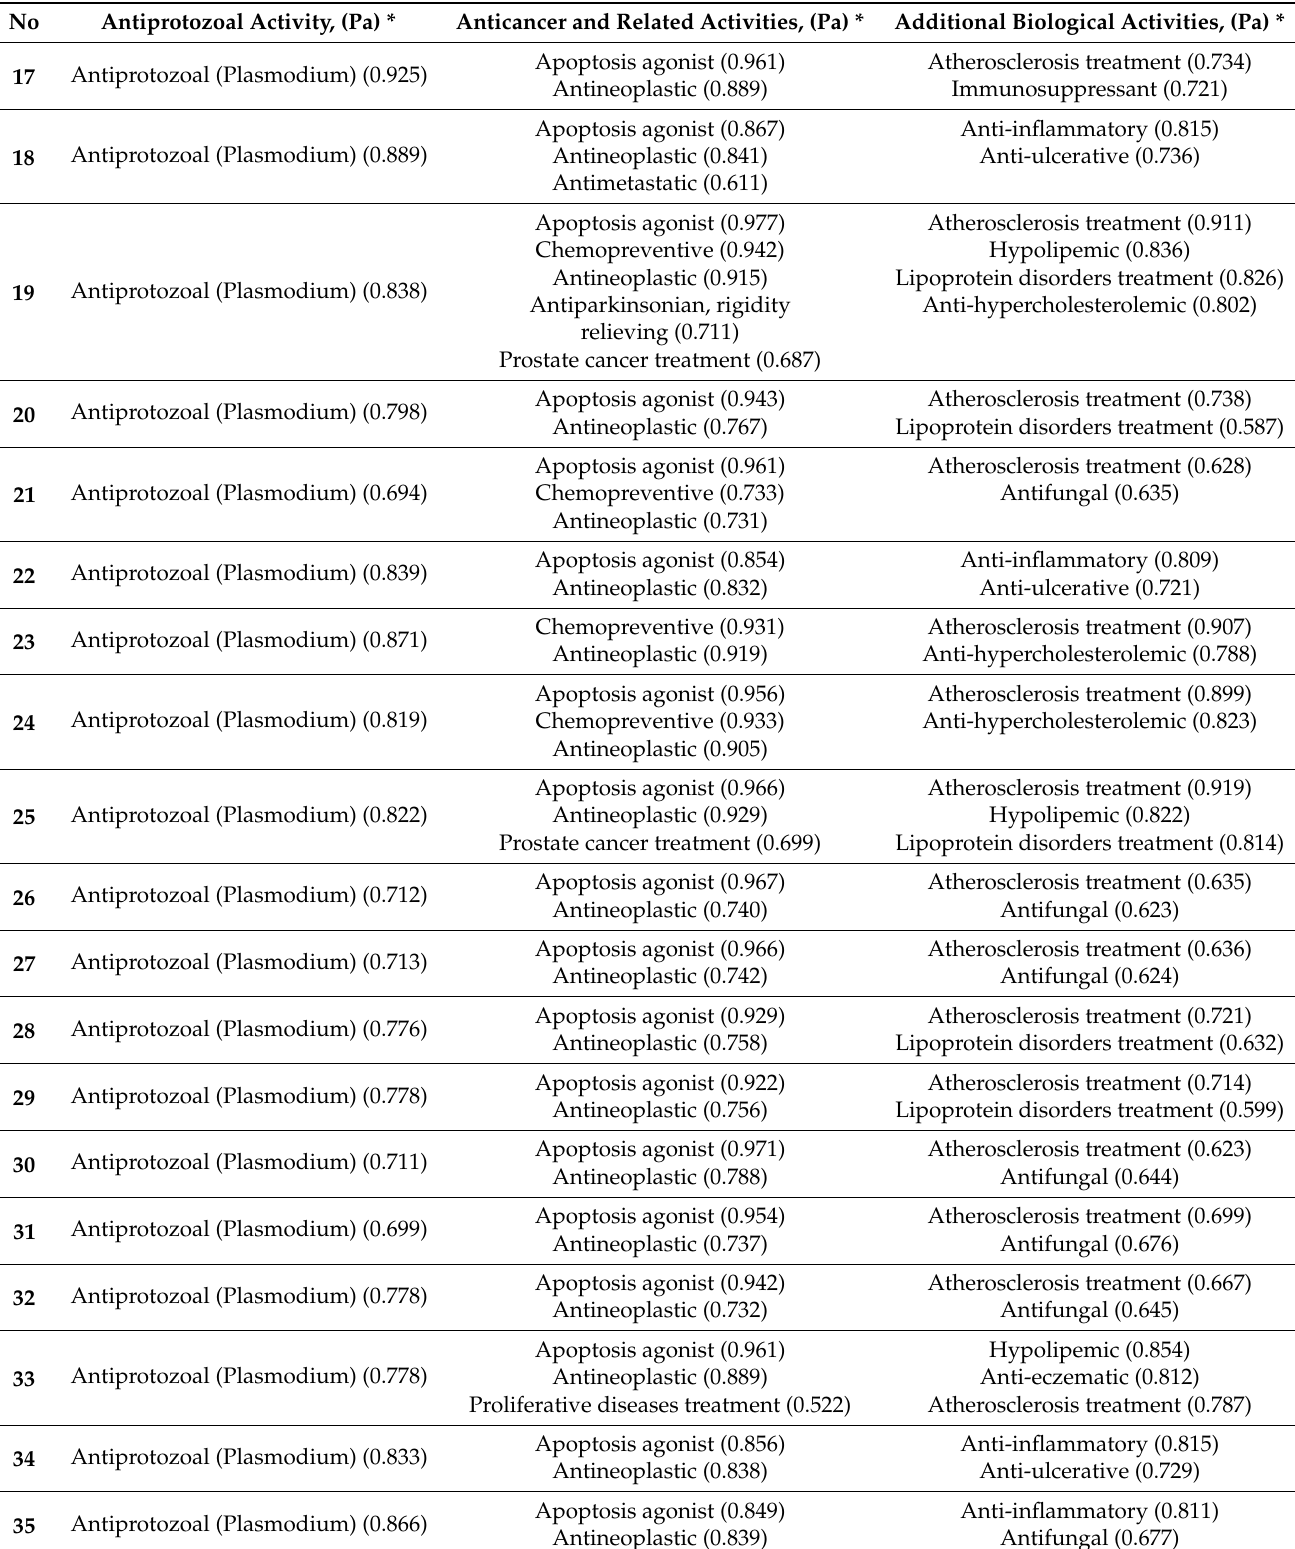
Table 2. Biological activity of natural polycyclic peroxides derived from marine